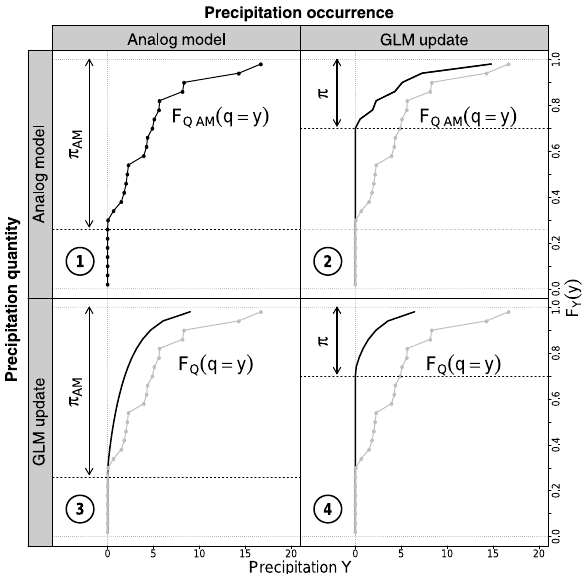
Figure 2. Illustrations of the four cases met for the issue of F Y (y) by the two-stage analog/regression model (SCAMP). Case 1: none of the occurrence and amount (quantity) GLMs could be retained during the regression stage: the backup analog model (AM 25 ) is used to predict the whole precipitation distribution. Case 2: only the occurrence GLM could be retained. It gives the estimated occur- rence probability. The distribution of non-zero precipitation comes from AM 25 . Case 3: only the amount (quantity) GLM could be re- tained. It gives the distribution of non-zero precipitation. The oc- currence probability is the empirical occurrence probability from AM 25 . Case 4: both occurrence and amount (quantity) GLMs could be estimated: they give, respectively, the occurrence probability and the distribution of non-zero precipitation, to be further combined for the full distribution of